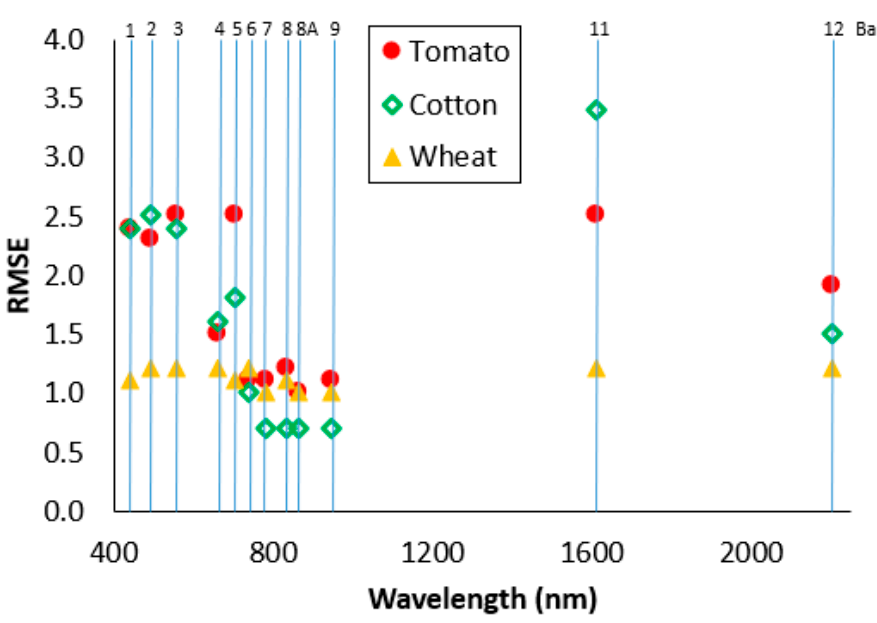
Figure 4. RMSE of Sentinel-2 bands in tomato, cotton, and wheat LAI estimation.